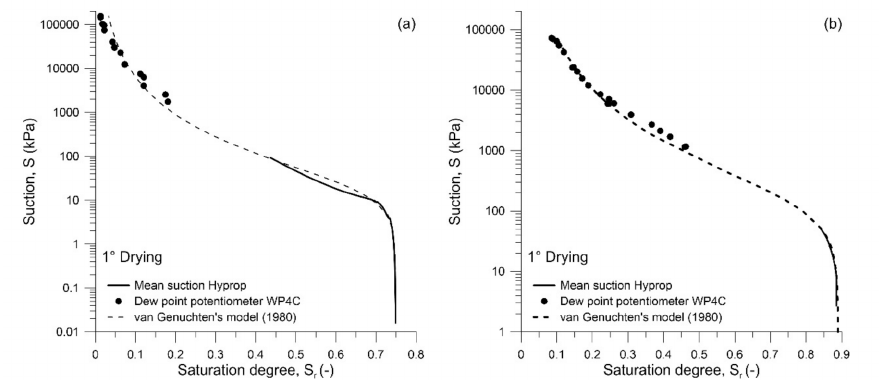
Figure 3. Elaboration of water retention data of ( a ) Agrigento sand and ( b ) Leendert de Boer- spolder silt.